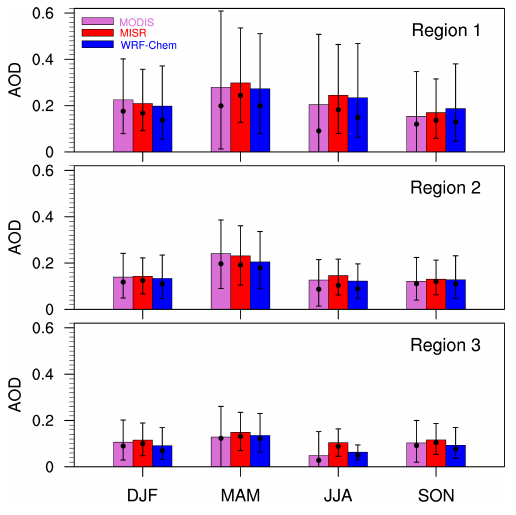
Figure 5. Seasonal mean 550nm AOD from the MISR and MODIS retrievals, and the corresponding WRF-Chem simulation averaged for the period 2010–2014 over the three sub-regions shown in Fig. 4. The values of bars represent the mean. The vertical lines represent 10th and 90th percentile values, and the black dots represent the median